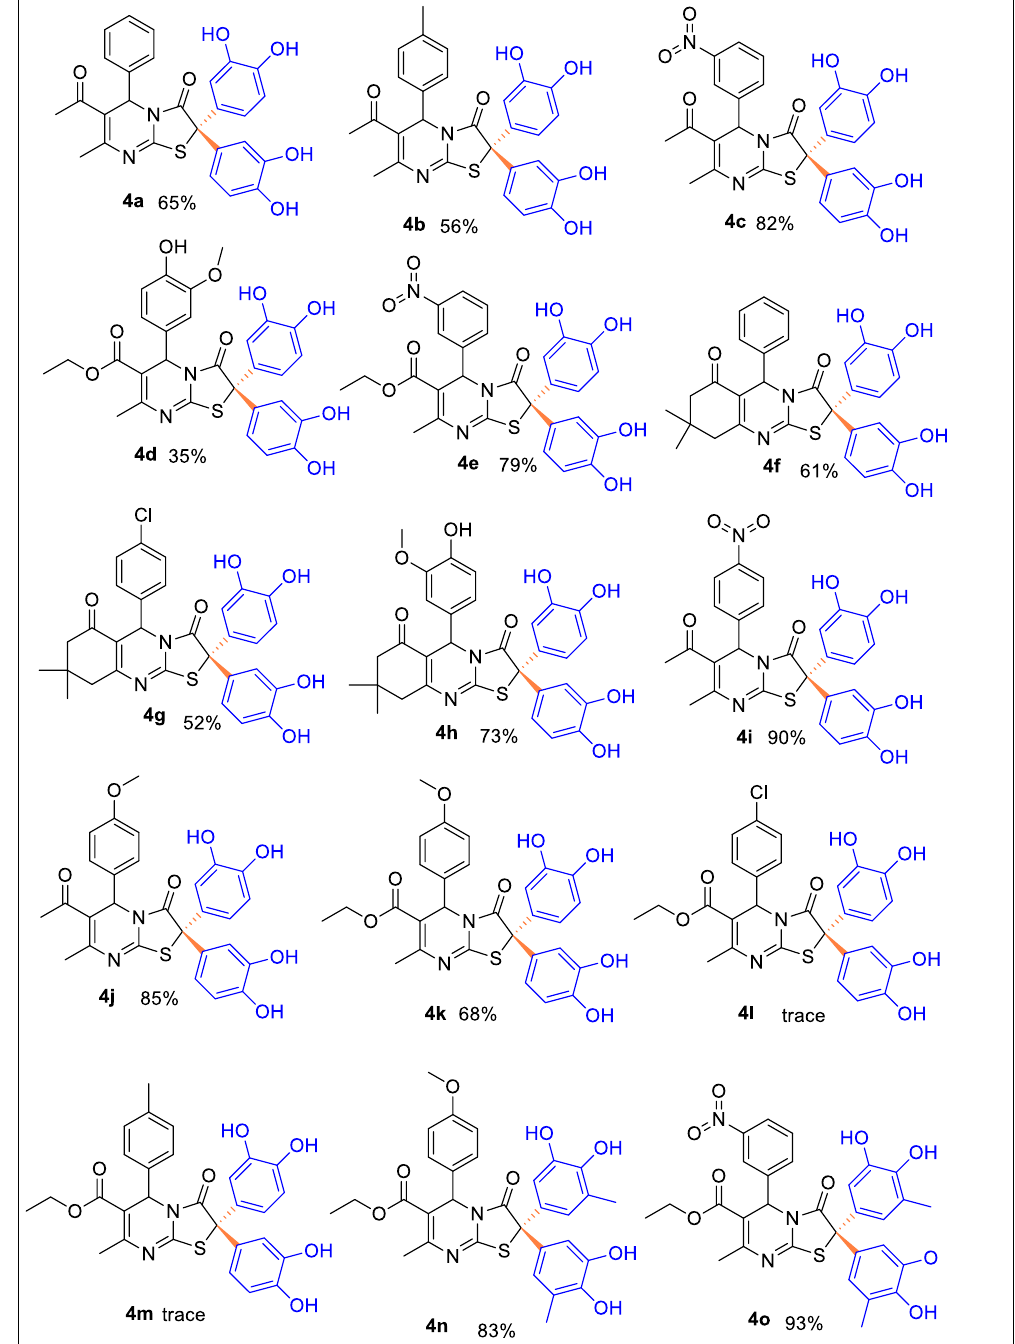
Table 2. Scope of reaction catalyzed by laccase. All reactions were performed using 2 (0.5 mmol), and 3 (1 mmol) at room